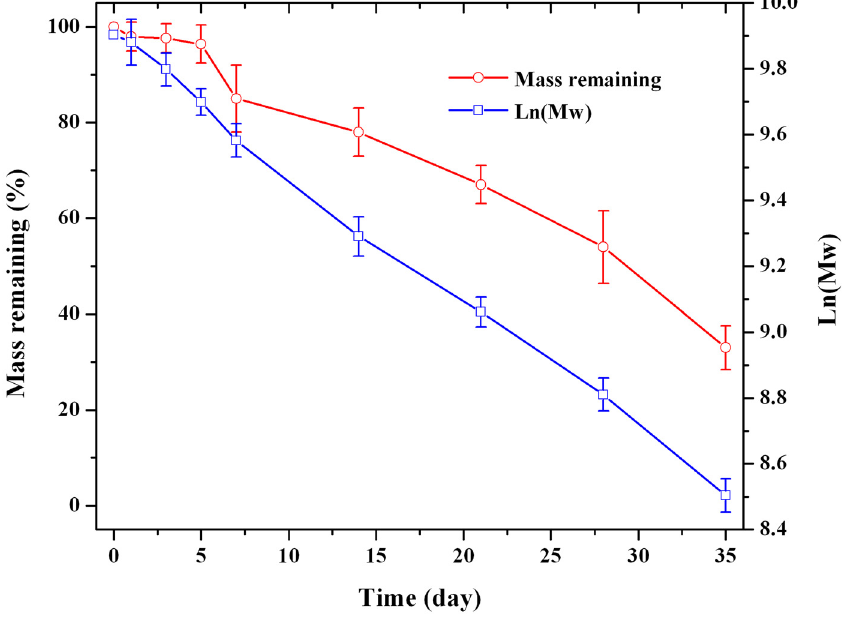
Fig 4. In vitro degradation study of nalmefene loaded PLGA microspheres. In 0.1M PBS (pH 7.4) at 37°C (n = 6). Mw represents molecular weight.